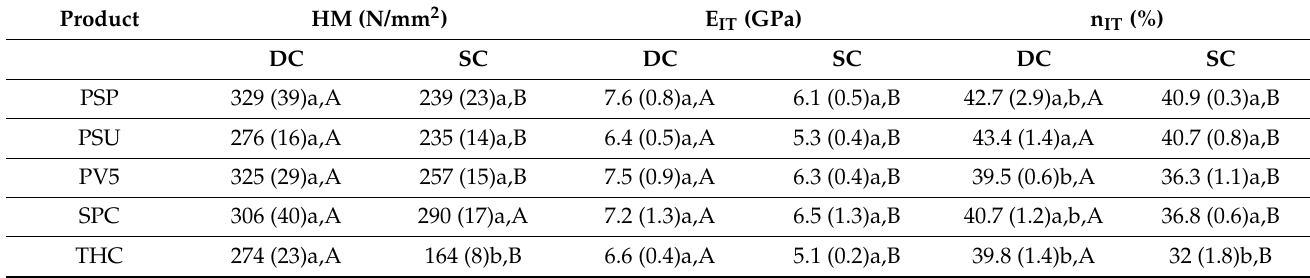
Table 2. The results of HM, E IT and n IT for the materials tested in dual-curing (DC) and self-curing (SC) modes *.